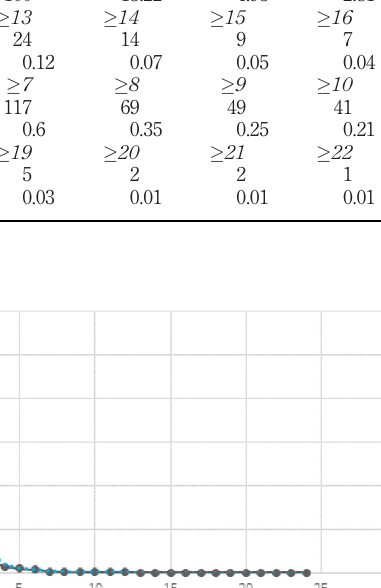
Figure 2. Number of directed edges that vary